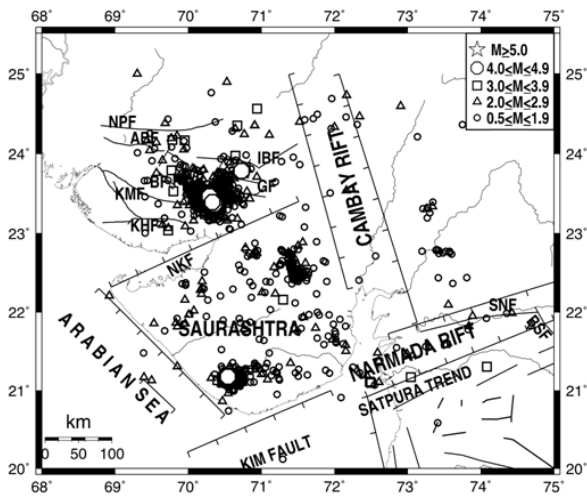
Fig. 2. Epicenters of earthquakes recorded by the ISR (Institute of Seismological Research) in the year 2008. (Reference from Annual report of ISR 08-09, available online on www.isr.gujarat.gov.in).